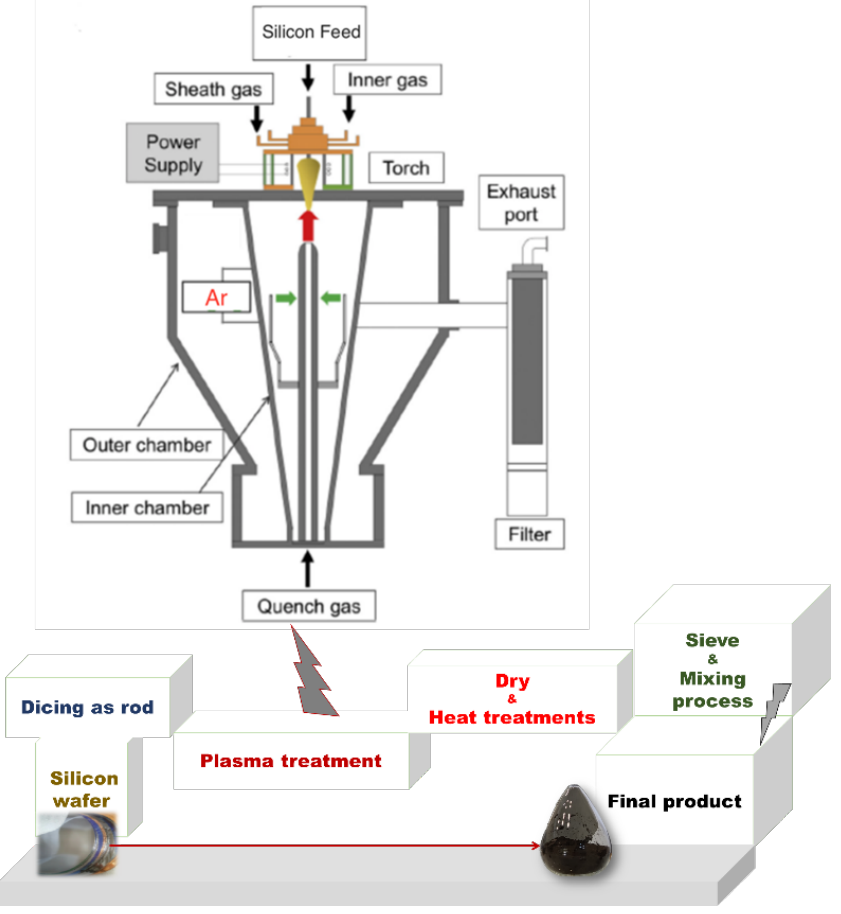
Figure 1. Schematic view of the plasma-assisted discharge method (PAD